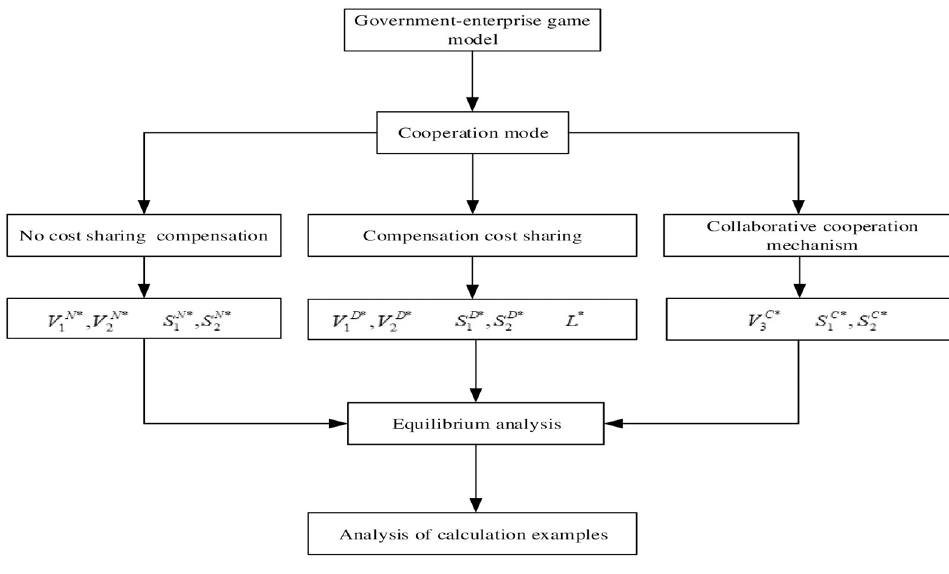
Fig 2. Research method